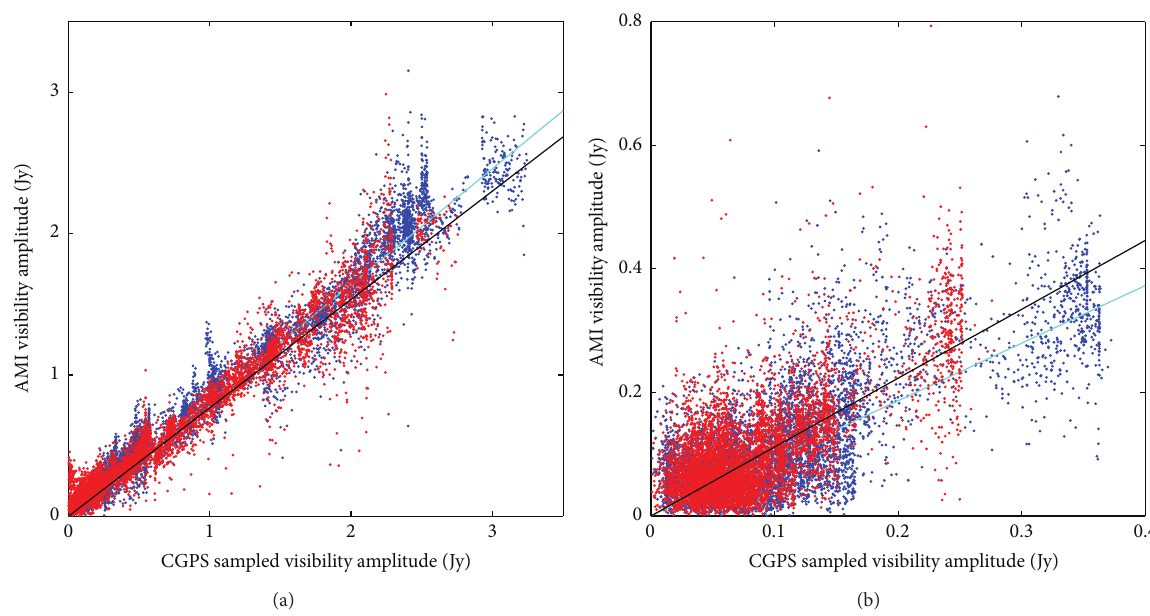
Figure 1: (a) S235 and (b) S140. Visibilities sampled from CGPS 1.42 GHz data are plotted on the x -axis, with the corresponding AMI observed visibilities on the y -axis for channels 3 (blue points) and 8 (red points). The solid cyan and black lines show the respective ratios derived from fitting elliptical Gaussians to the maps, for example (integrated flux density from AMI channel map)/(integrated flux density from CGPS map sampled with corresponding AMI channel uv -coverage). There is a very good correlation between the sampled and true AMI visibilities, indicating that the morphology that AMI observes is very similar to that observed by CGPS.